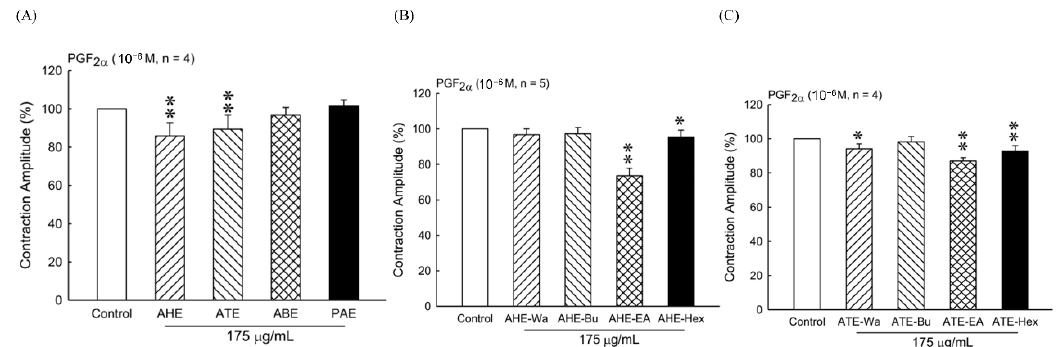
Figure 1. Effect of adlay on the uterine contraction induced by PGF 2 α (10 − 6 M). ( A ) Effect of different parts of adlay on isolated rat’s uterine contractions. ( B ) Inhibitory effect of AHE subfractions on isolated rat’s uterine contraction. ( C ) Inhibitory effect of ATE subfractions on isolated rat’s uterine contraction. Data represent mean values ± SD. * p < 0.05, ** p < 0.01 compared with control. AHE, ethanolic extracts of adlay hull; ATE, ethanolic extracts of adlay testa; ABE, ethanolic extracts of adlay bran; PAE, ethanolic extracts of polished adlay; AHE-Wa, H 2 O fraction of adlay hull ethanolic extract; AHE-Bu, 1-butanol fraction of adlay hull ethanolic extract; AHE-EA, ethyl acetate fraction of adlay hull ethanolic extract; AHE-Hex, n-hexane fraction of adlay hull ethanolic extract; ATE-Wa, H 2 O fraction of adlay testa ethanolic extract; ATE-Bu, 1-butanol fraction of adlay testa ethanolic extract; ATE-EA, ethyl acetate fraction of adlay testa ethanolic extract; ATE-Hex, n-hexane fraction of adlay testa ethanolic extract.